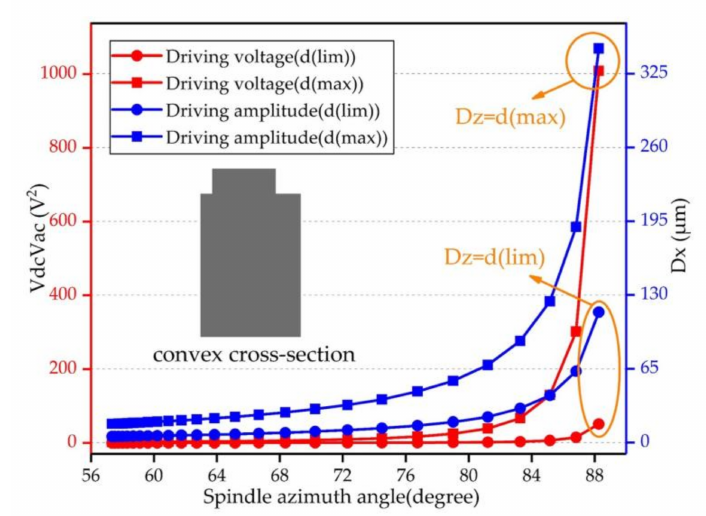
Figure 5. Driving voltage and driving amplitude of the convex cross-section beam—this figure has two Y axes. The ultimate in-plane displacement of the driving mode is fixed, the spindle azimuth is changing. The left axis shows the voltage required to achieve the ultimate in-plane displacement of the driving mode under different spindle azimuth angles. The right axis shows the corresponding ultimate driving amplitude of the